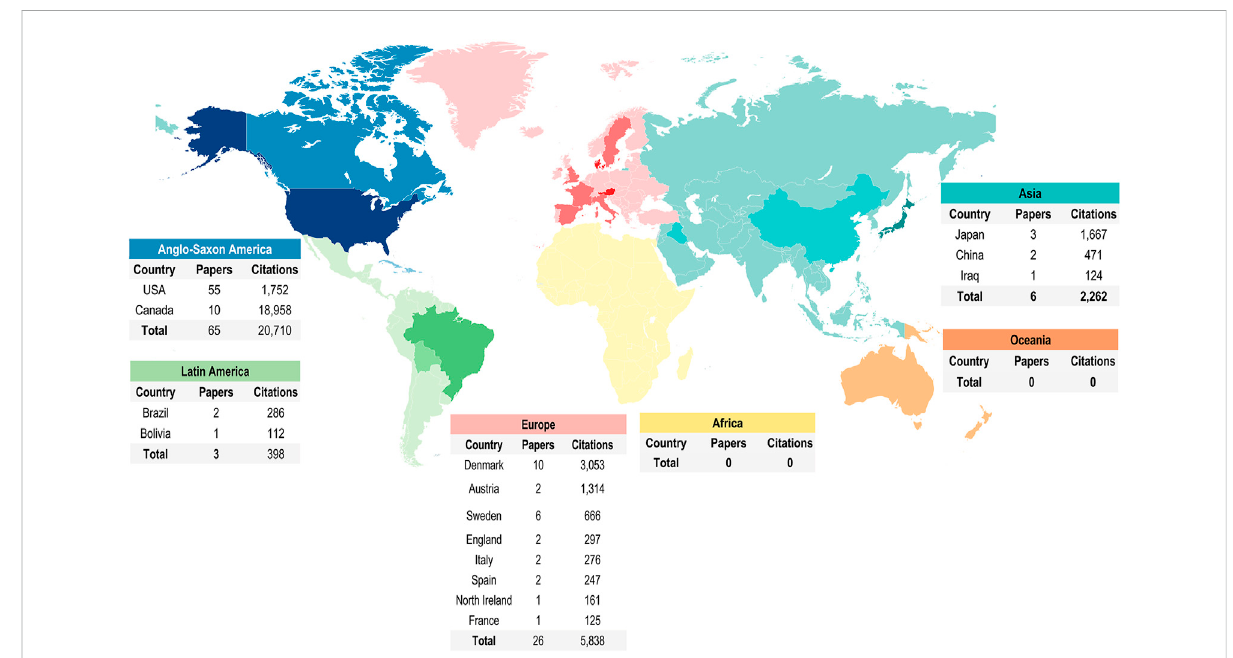
FIGURE 1 Worldwide distribution of the top 100 most-cited papers in maternal exposure to MeHg and offspring health